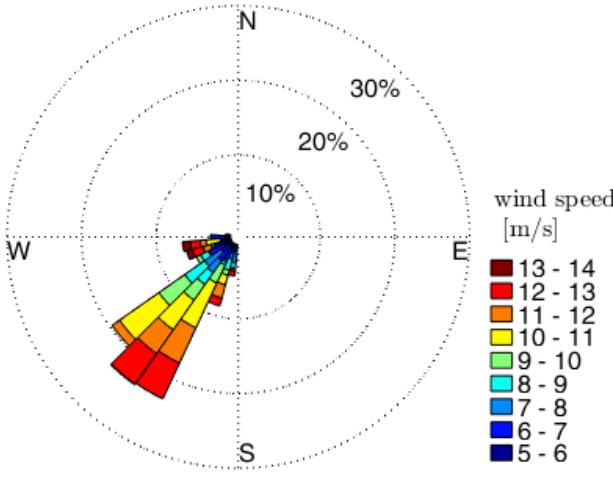
Figure 3. Wind rose of one-minute mean wind speeds at the height of 100m (averaged over the radar domain) observed by the dual-Doppler radar system during the period covered in this